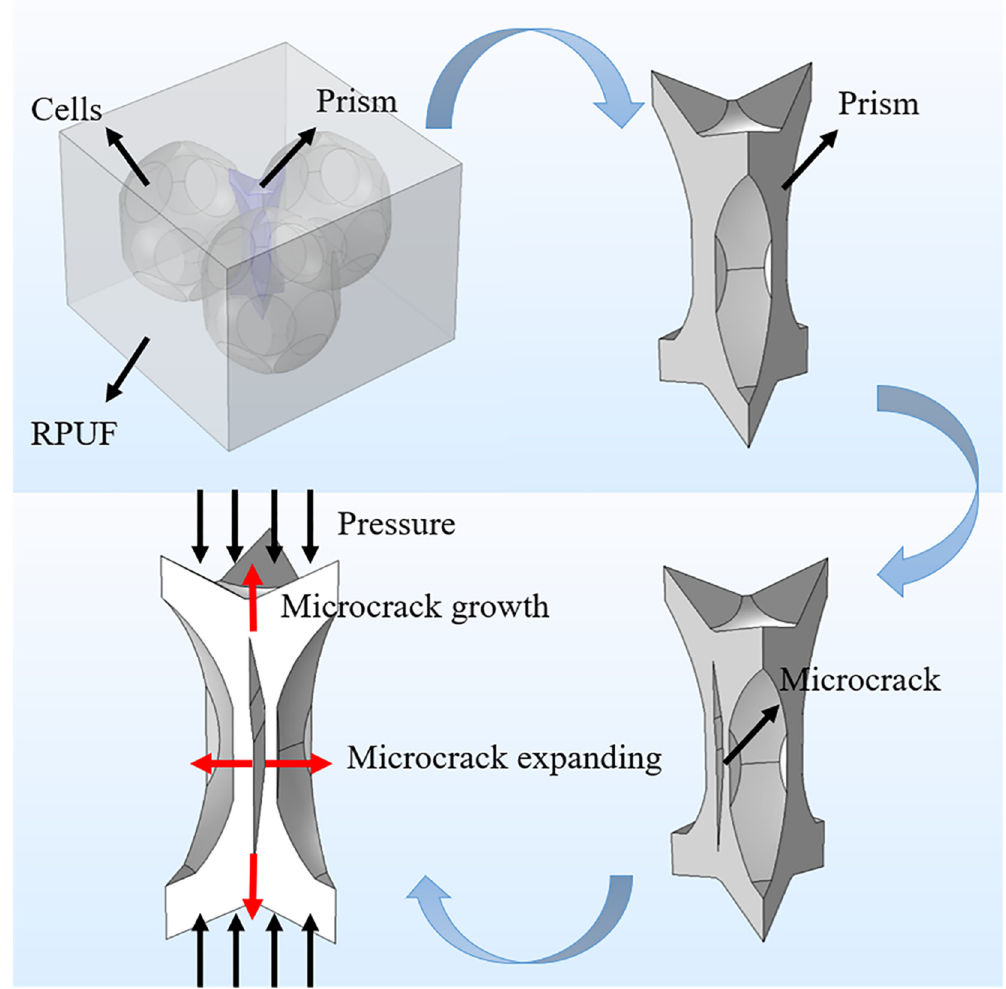
Figure 6. Schematic diagram of failure forms of cell prism (including microcracks) of rigid polyurethane foam.